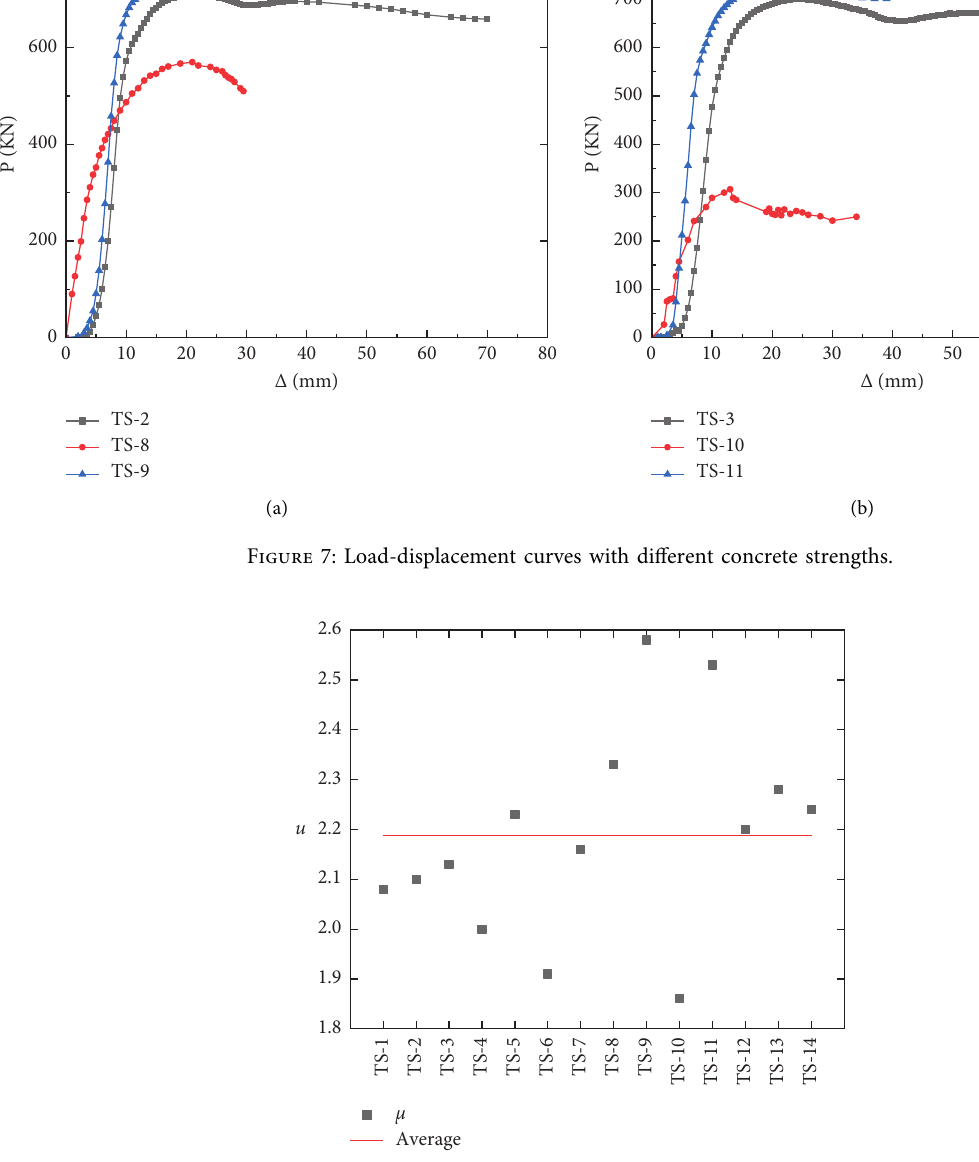
Figure 8: Displacement ductility coefficient.